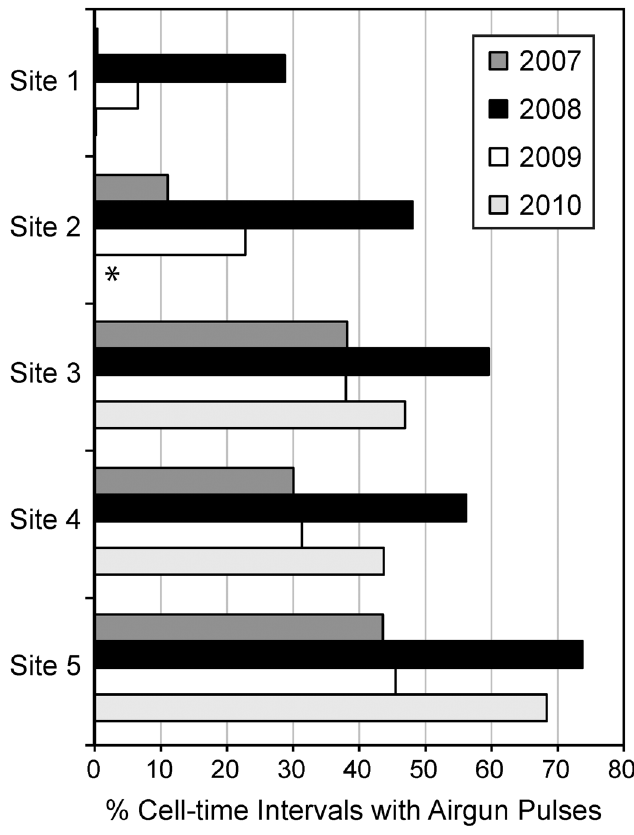
doi:10.1371/journal.pone.0125720.g007